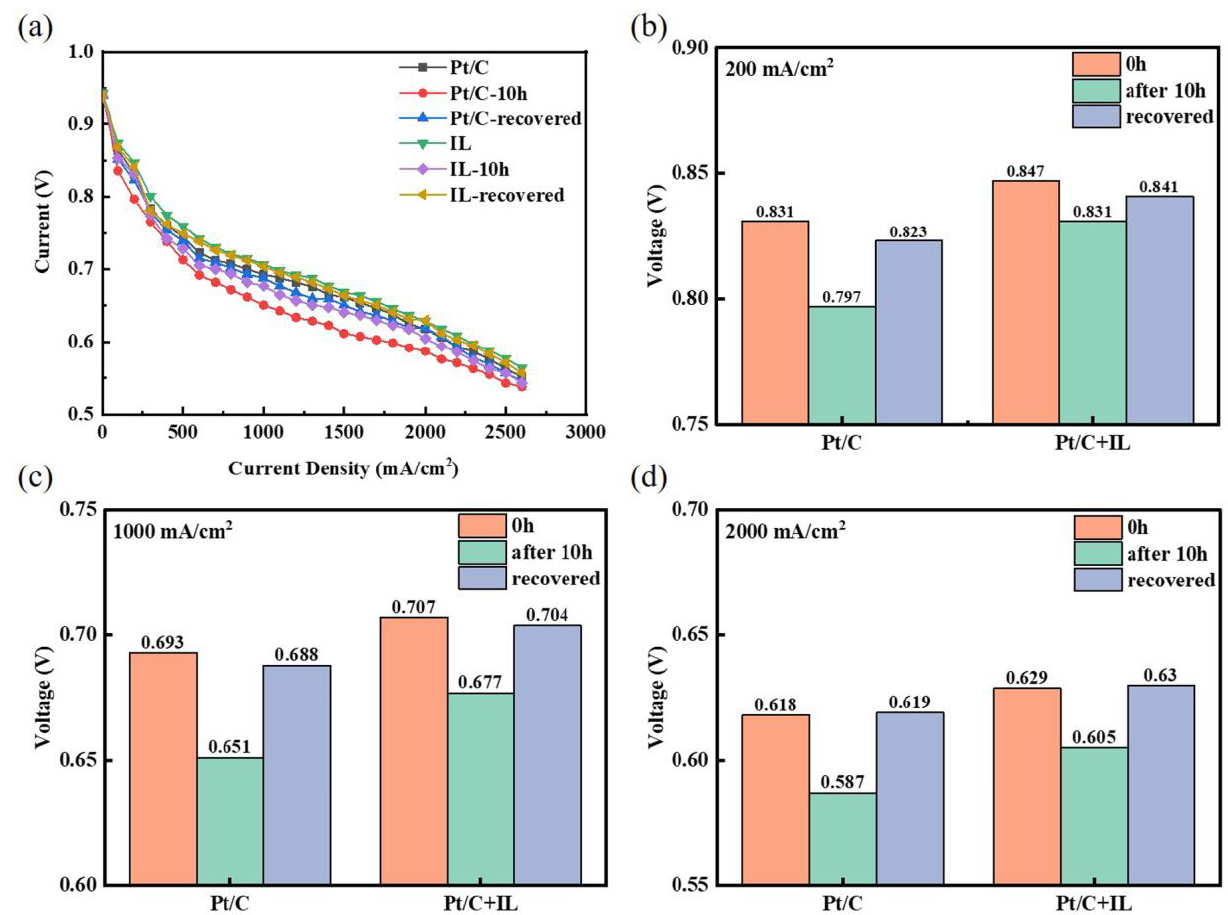
Figure 4. Polarization curves of Pt/C and Pt/C + IL ( a ); voltages at low ( b ), medium ( c ), and high ( d ) current densities.